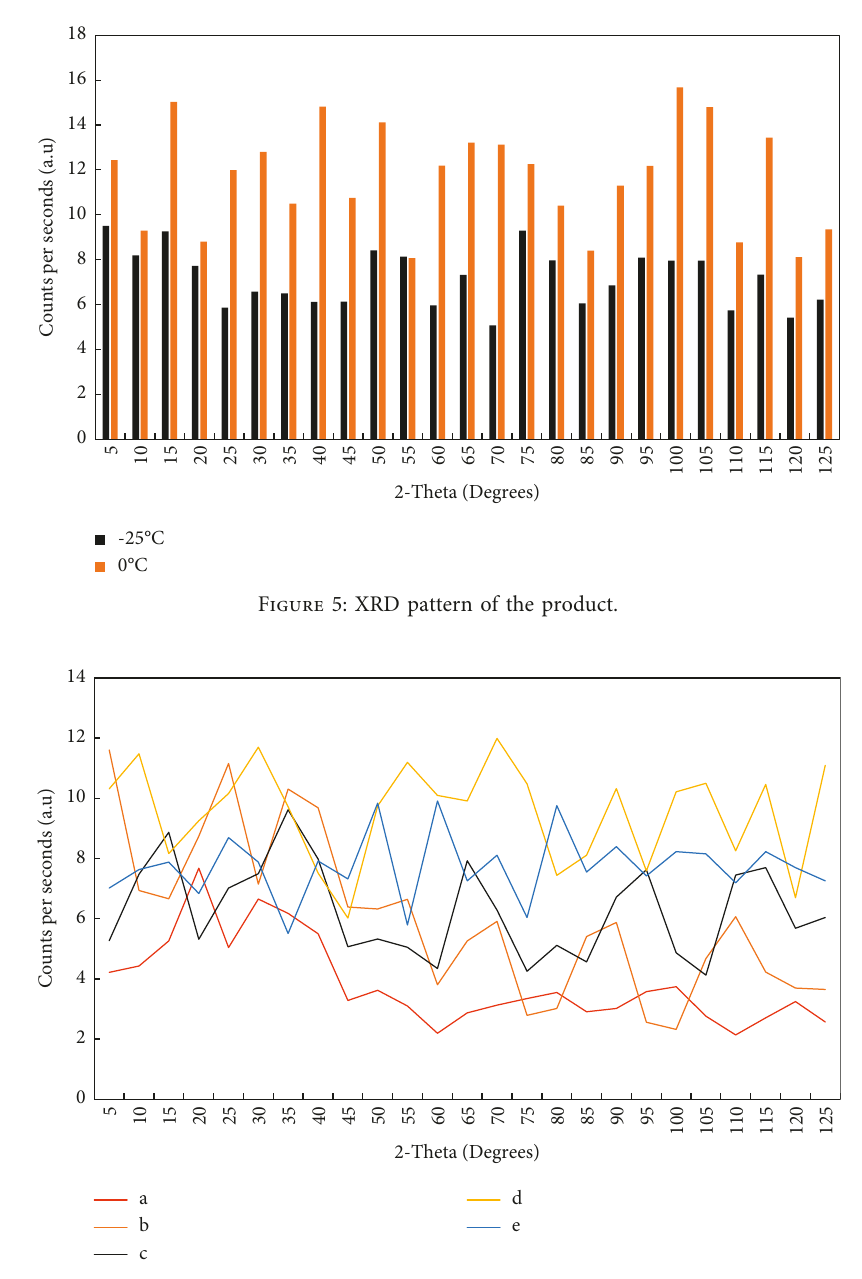
Figure 6: XPS full spectrum of BaTiO3/TiO2 heterojunction and TiO2 nanotube